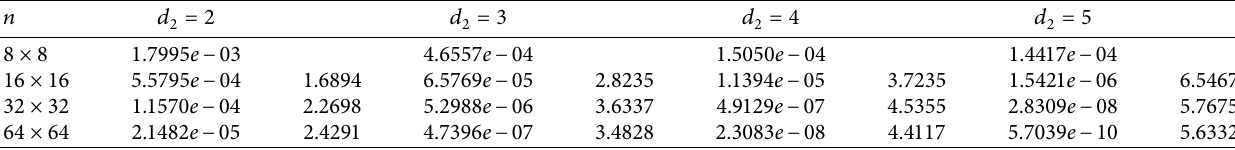
� d � 8. 1 2 � 7 and t � 1. 1